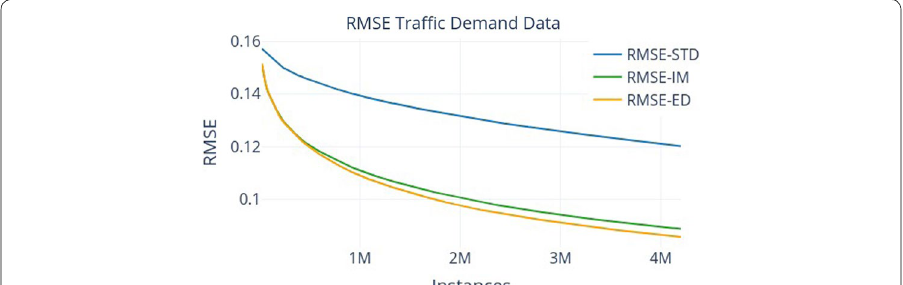
Fig. 4 RMSE comparison for the traffic demand data